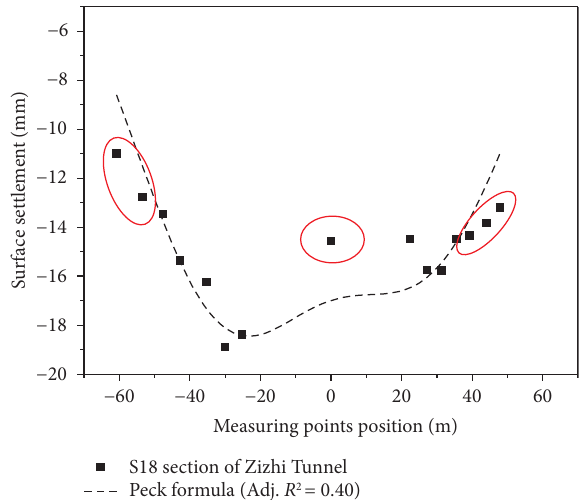
Figure 2: Surface settlement of S 18 section by the Peck